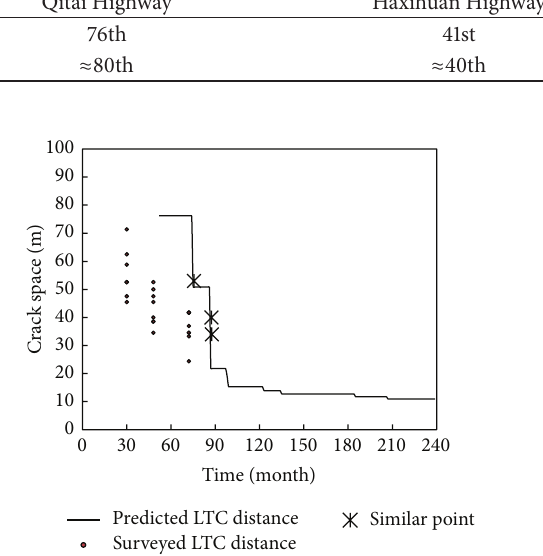
Figure 10: Predicted thermal cracking versus survey thermal cracking on Changping Highway.